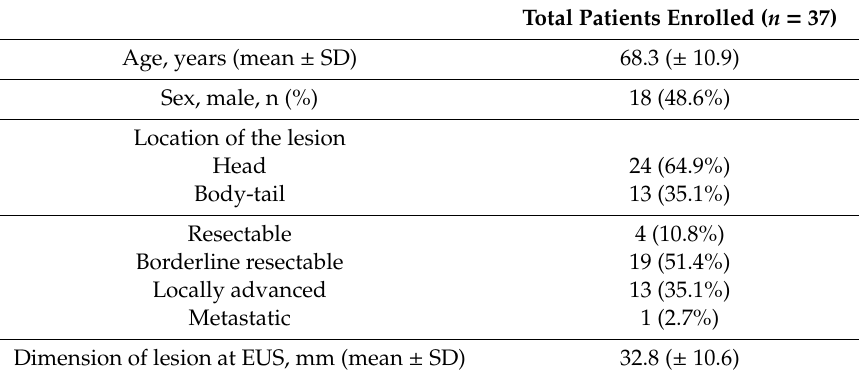
Table 1. Patient and tumor